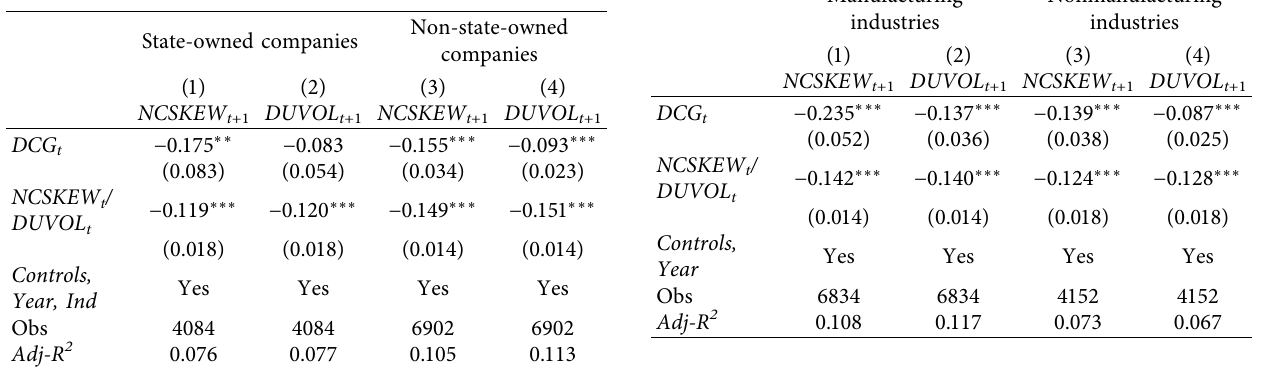
Table 3: Analysis of heterogeneity: based on the nature of business ownership.